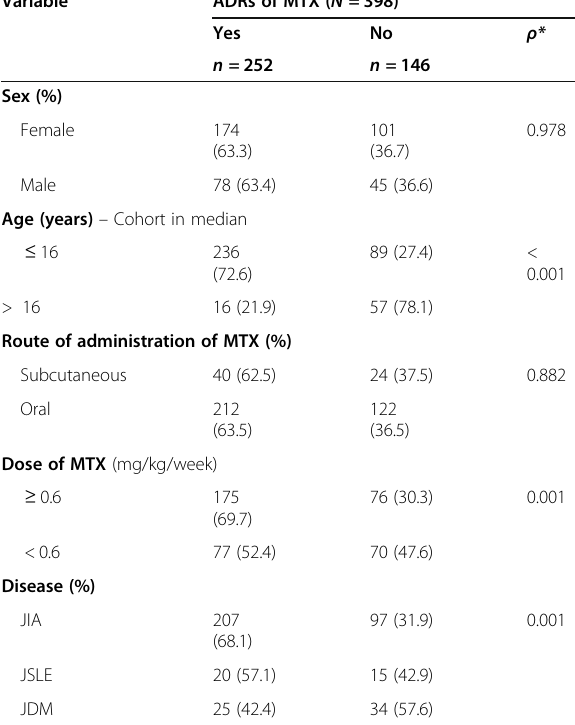
N - number of patients treated with MTX, JIA - juvenile idiopathic arthritis, JSLE - juvenile systemic lupus erythematosus, JDM - juvenile dermatomyositis * Chi Pearson square or Fisher ’ s exact. P < 0.05